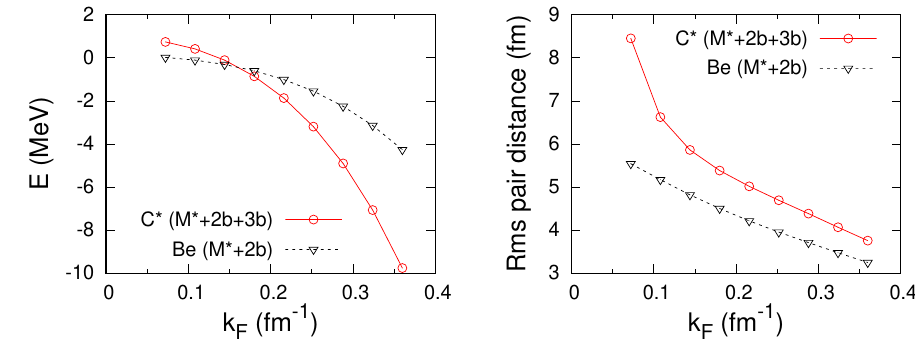
Figure 1. Energies (left) and root-mean-square pair distance (right) of the ground state of 8 Be and the Hoyle state C ∗ in neutron matter of the Fermi momentum k F . M ∗ , 2 b , and 3 b denote calculations with the e ff ective mass, induced two- and three-alpha interactions,